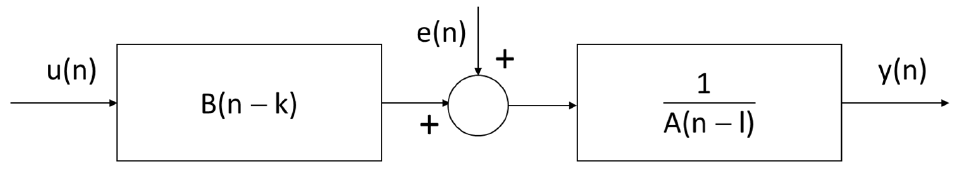
Figure 8. Graphical representation of the ARX model (l > k).